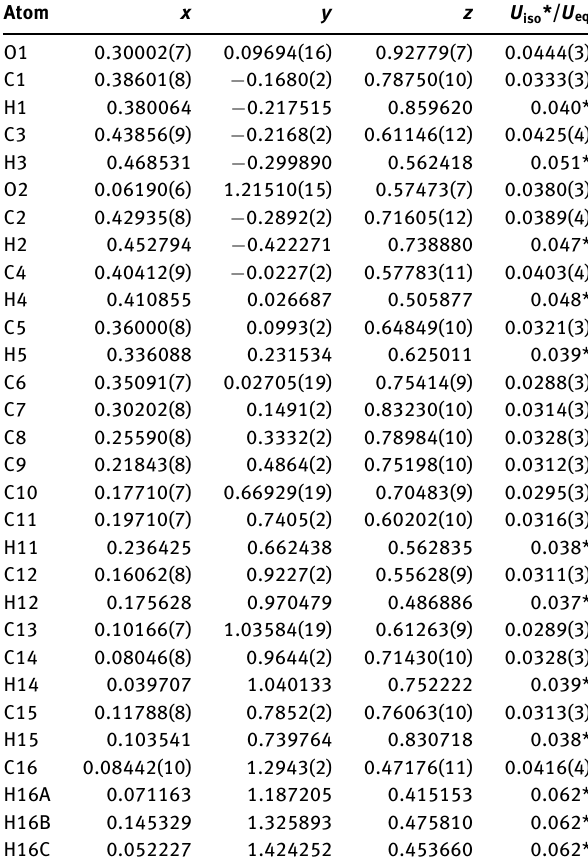
Table 2: Fractional atomic coordinates and isotropic or equivalent isotropic displacement parameters (Å 2